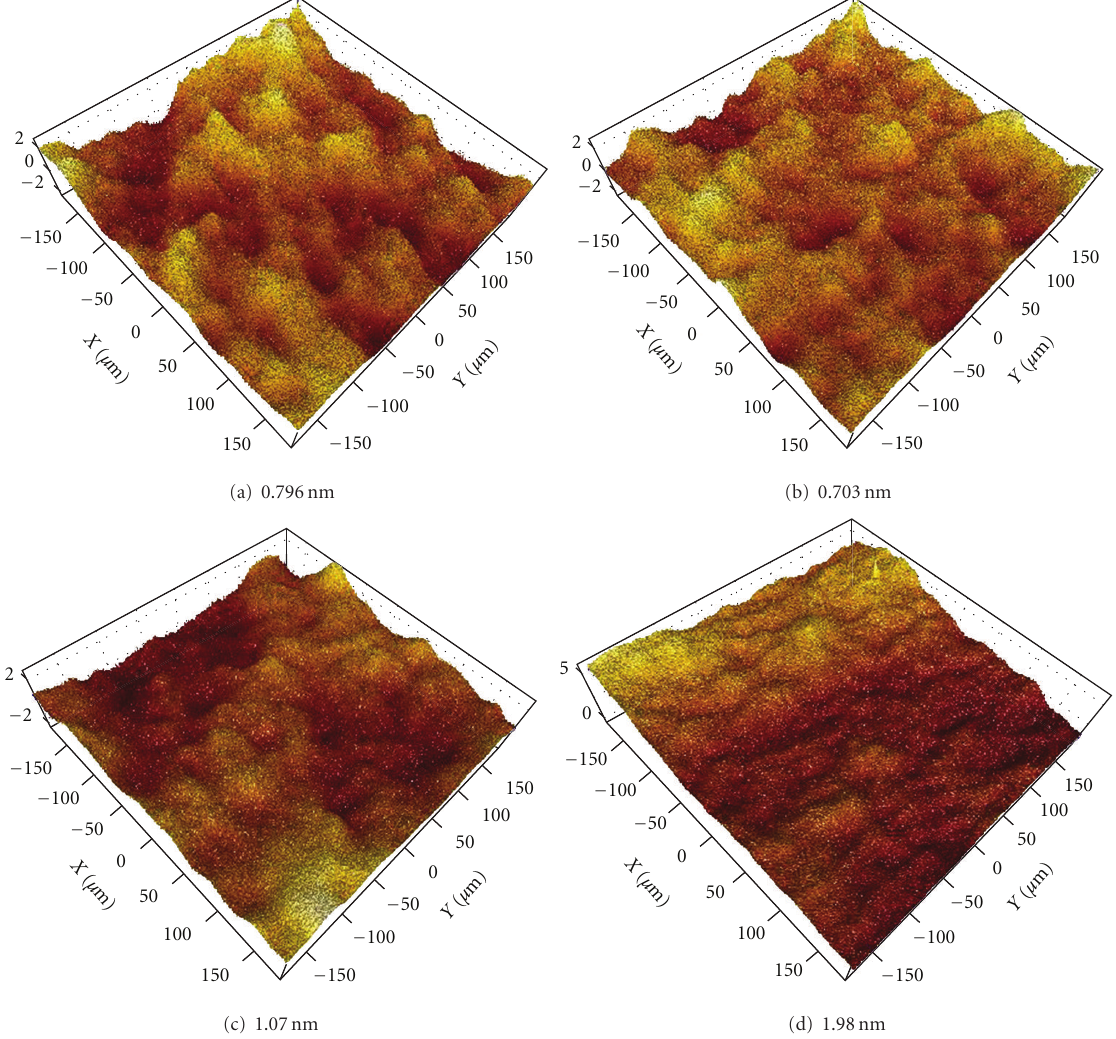
Figure 3: RMS as a function of rapid thermal annealing temperature: (a) 750, (b) 850, (c) 900, and (d) 950 ◦